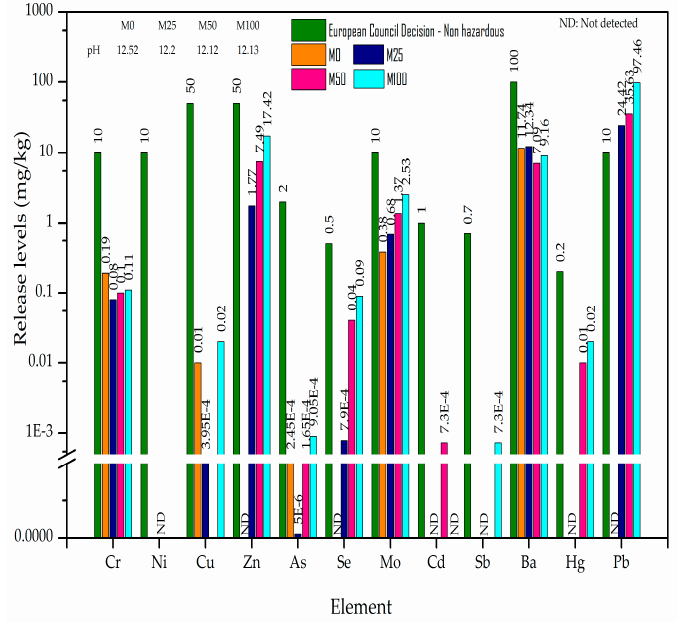
Figure 2. Release level of elements in mortars (UNE-EN